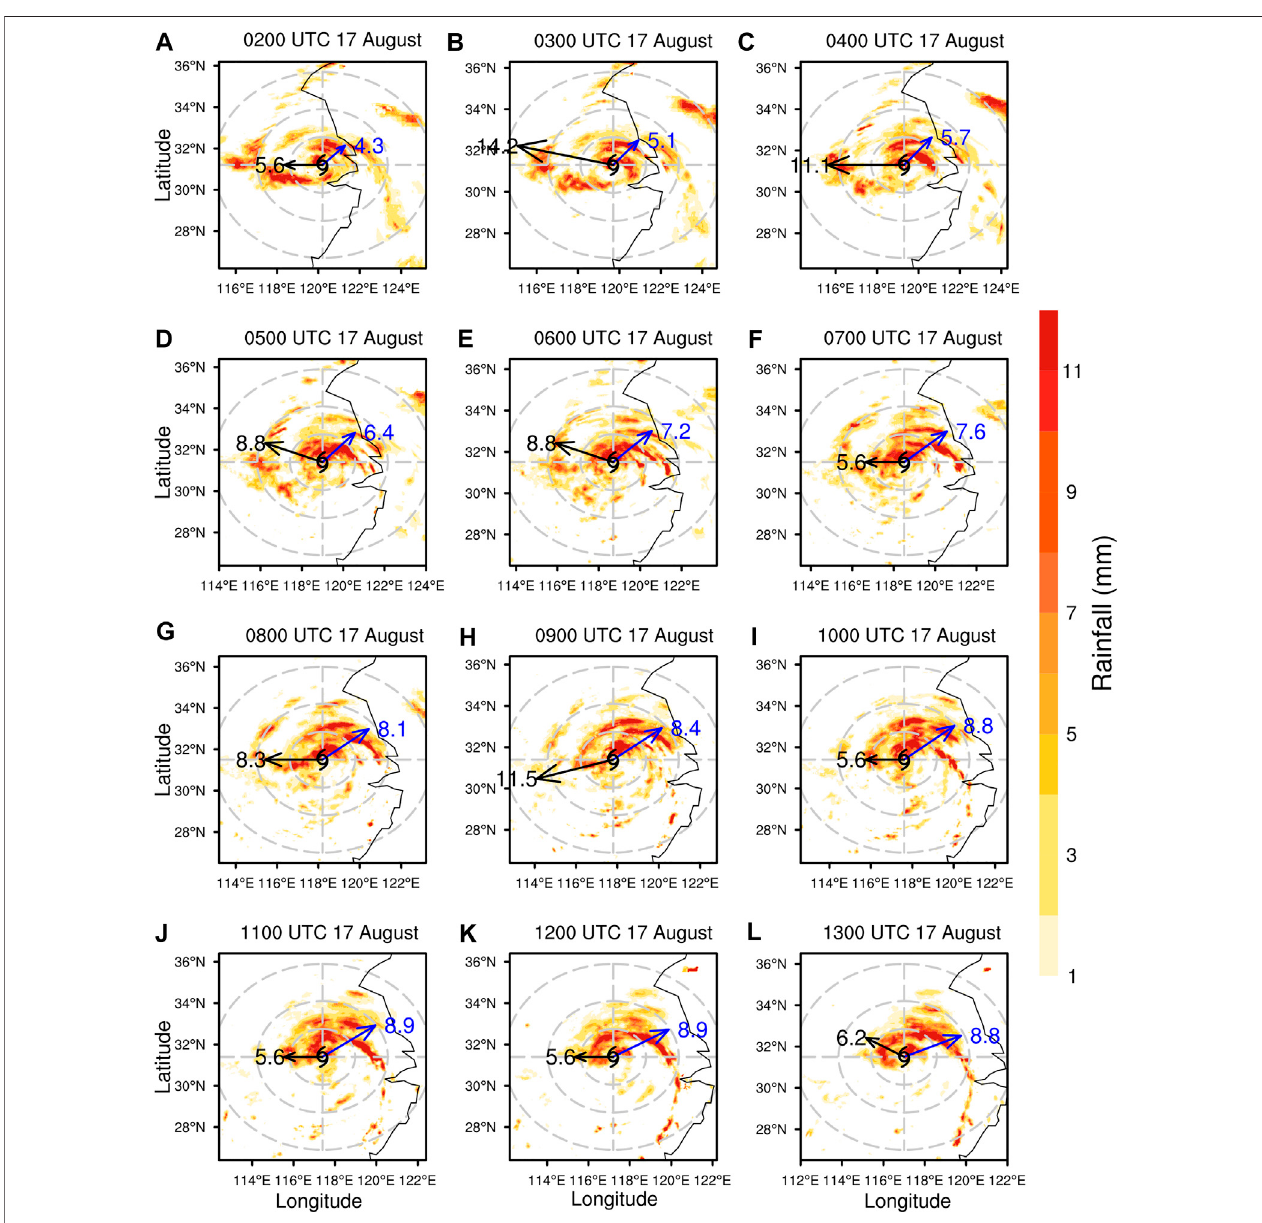
FIGURE7| Sameas Figure6 ,butat (A) 0200, (B) 0300, (C) 0400, (D) 0500, (E) 0600, (F) 0700, (G) 0800, (H) 0900, (I) 1,000, (J) 1,100, (K) 1,200, (L) 1300UTC 17 August.